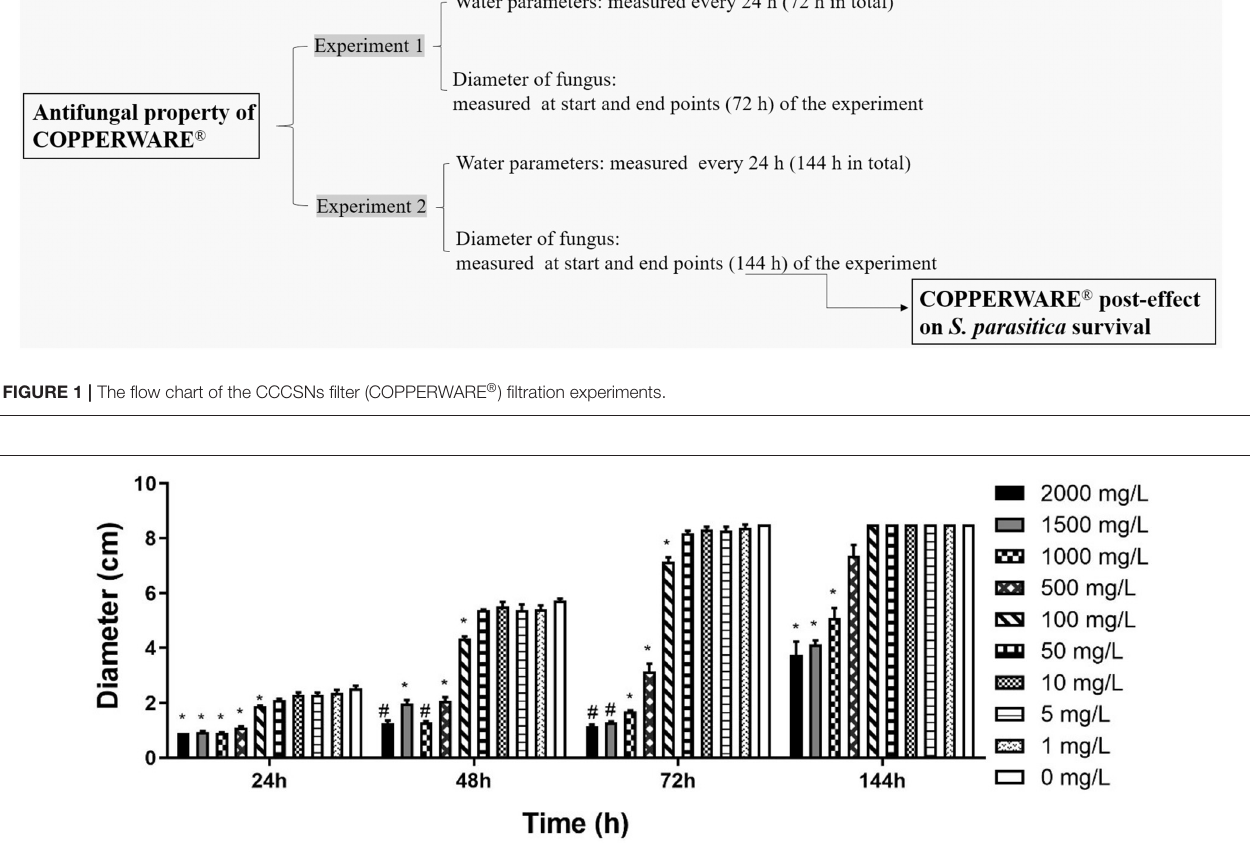
Frontiers in Veterinary Science |